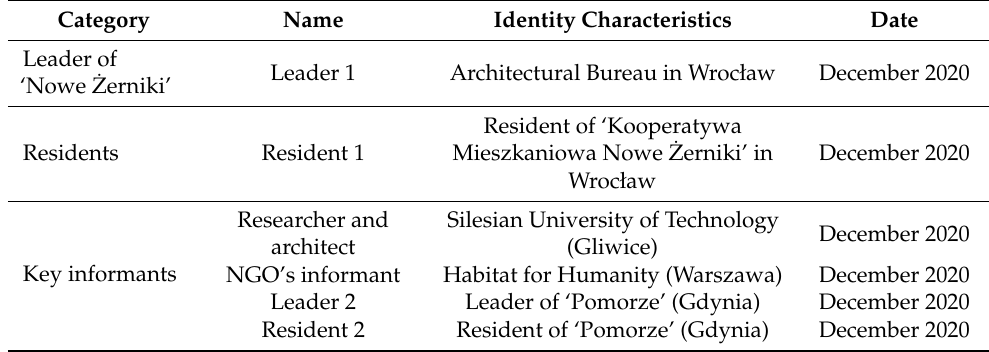
Table 1. Interviews with the actors involved in housing collaboratives in